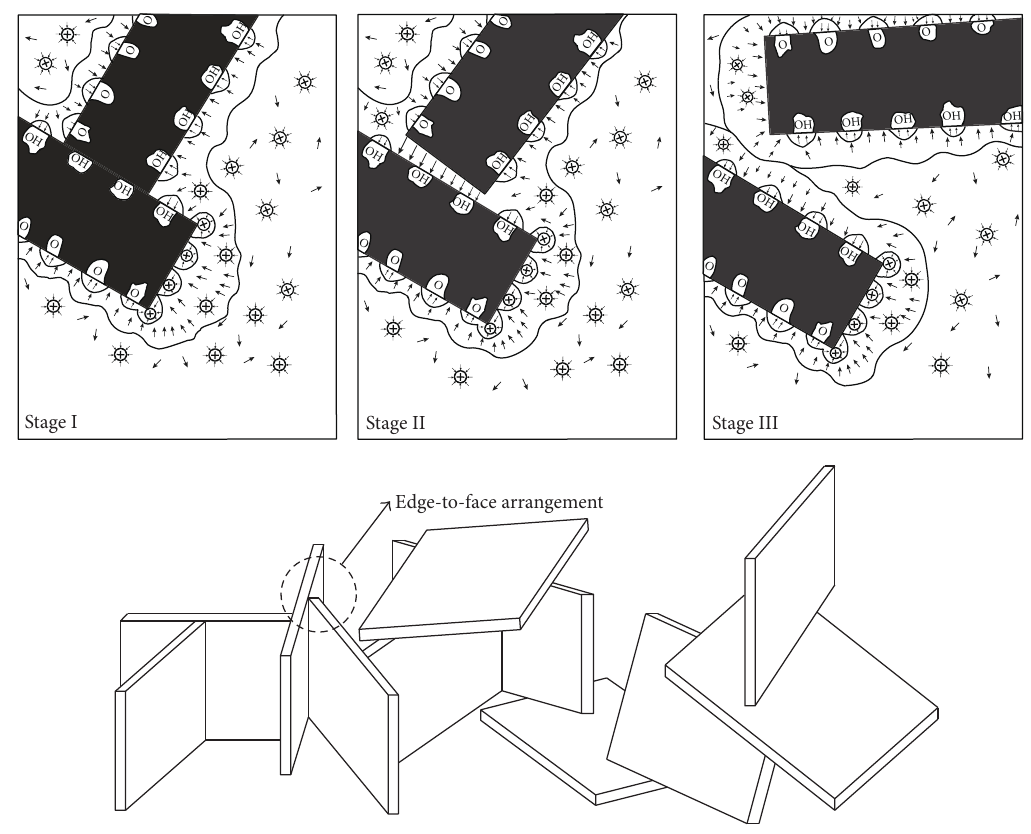
Figure 8: Various stages of edge-to-face arrangements under